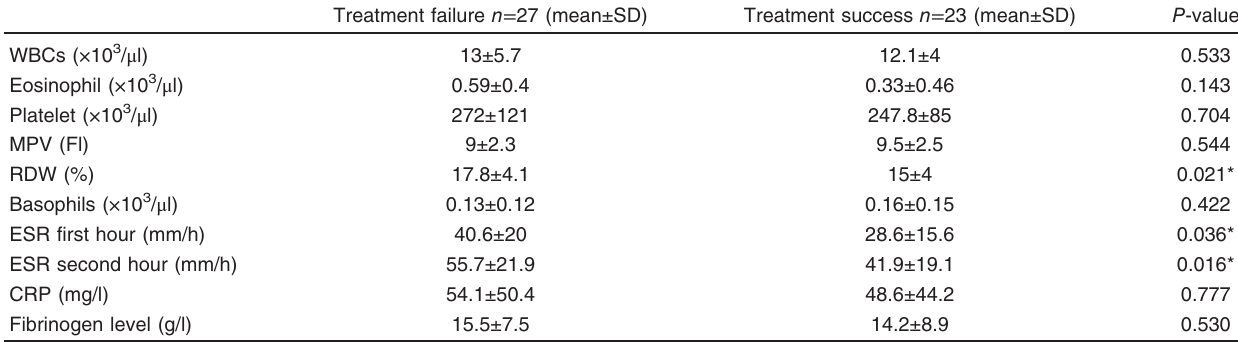
ROC curve of optimal cut-off level of PaCO 2 ( ≥ 59.5) associated with treatment failure with sensitivity of 77.8% and specificity of 66.2% (figure A). ROC curve of optimal cut-off level of PaO 2 ( ≤ 43.5) associated with treatment failure with sensitivity of 81.5 % and specificity of 69.6% (figure